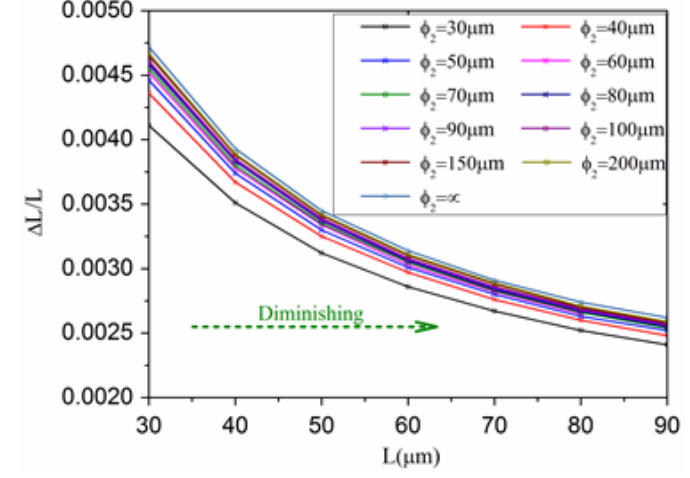
Figure 9. The relation curve between cavity length L and ∆ L / L .